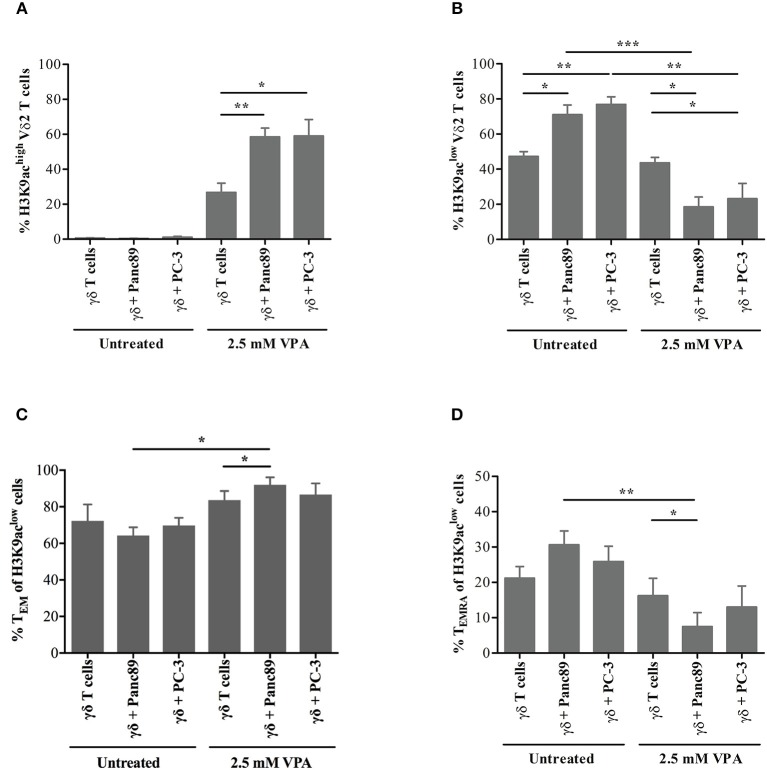
H3K9 acetylation-associated memory phenotype of γδ T cells upon in vitro co-culture with tumor cells. γδ T cell lines generated from 12 days zoledronic acid-stimulated PBMC were co-cultured with 2.5 mM VPA pre-treated Panc89 and PC-3 cells. After 24 h of co-culture, cells were harvested and stained with FITC-conjugated Vδ2, APC-H7-conjugated CD27, PE-Cy7-conjugated CD45RA and Pacific Blue-conjugated H3K9ac antibodies. Based on flow cytometry gating strategy described in the Supplementary Figure 5, Vδ2-gated cells were defined as (A) H3K9achigh and (B) H3K9aclow in solo- or co-culture with Panc89 and PC3 cells in the presence and absence of 2.5 mM VPA. The proportions of H3K9aclow cells within Vδ2 T cells with (C) TEM and (D) TEMRA phenotype from the co-culture with Panc89 or PC-3 with or without 2.5 mM VPA treatment are shown. Data represented as mean ± S.E. of four independent experiments. Statistical significance is shown by *, **, *** for p-values < 0.05, 0.01 and 0.005, respectively.